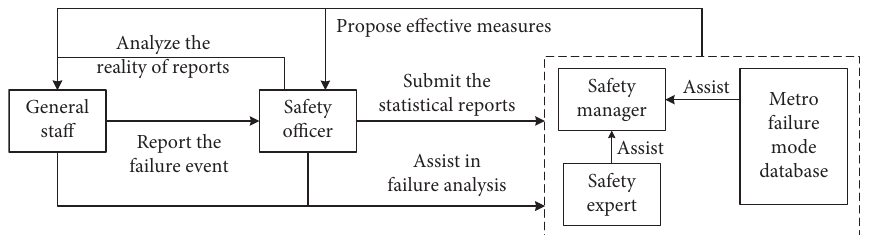
Figure 9: The interactions among general staff, safety officers, safety manager, and safety expert.